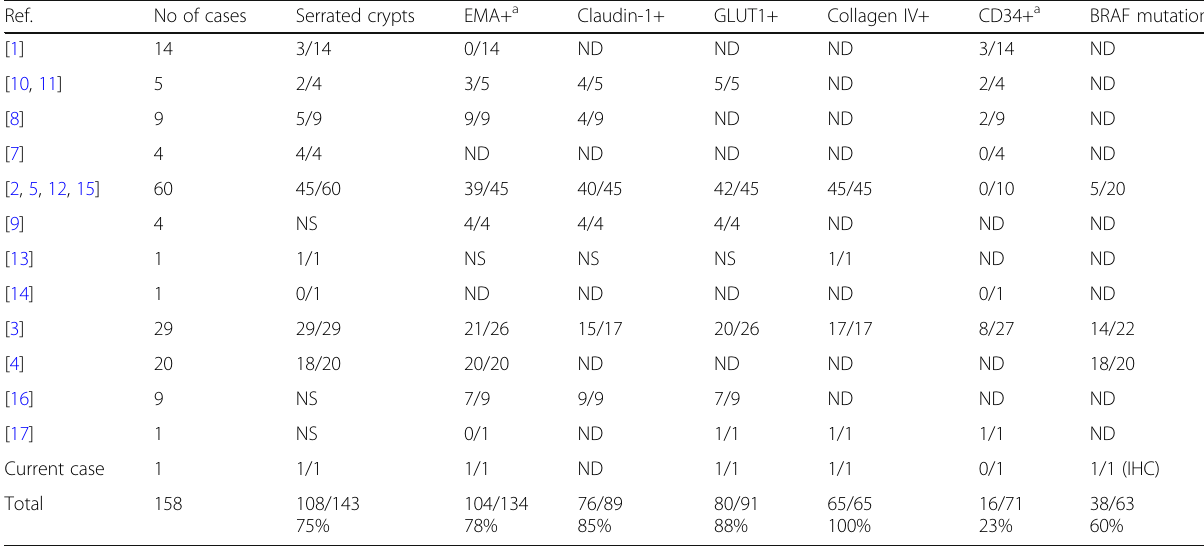
Table 2 Histological, immunohistochemical and molecular findings in reported colorectal perineuriomas (Total: 158)